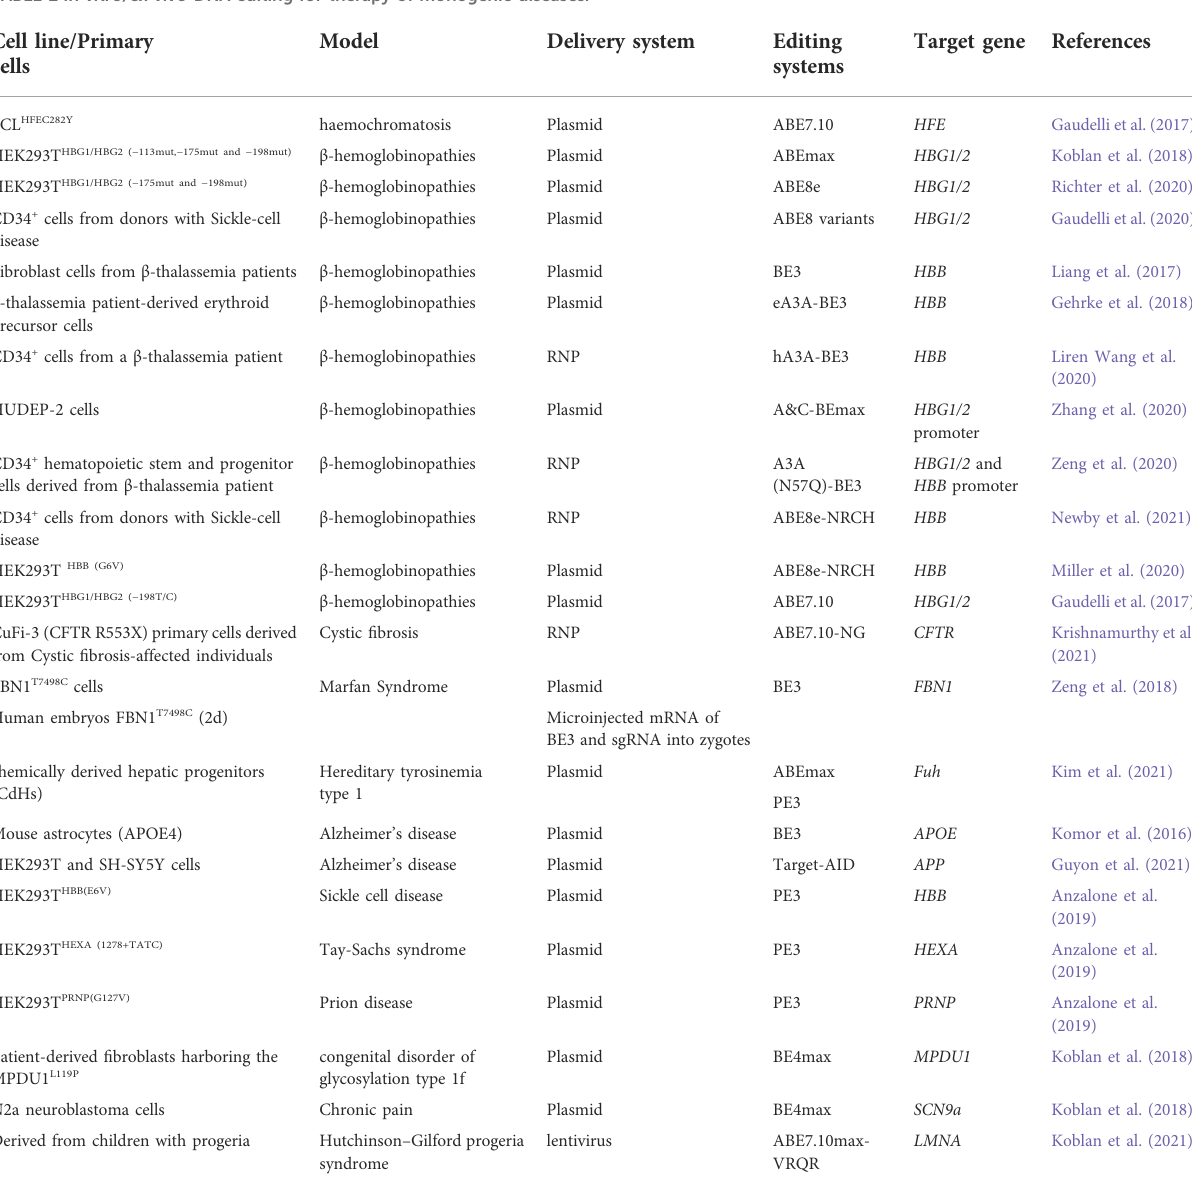
TABLE 2 In vitro/ex vivo DNA editing for therapy of monogenic